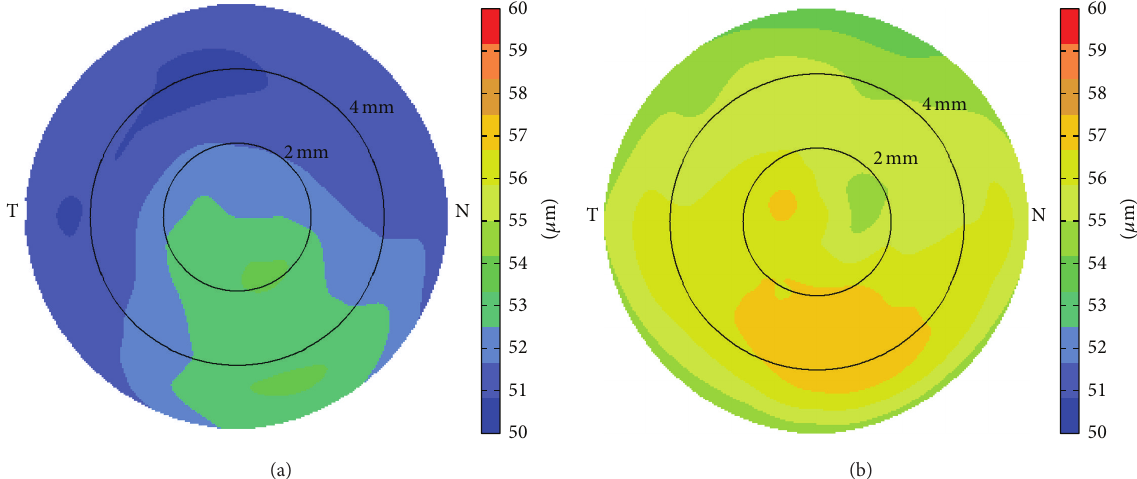
Figure 1: Average epithelial thickness map (a) before LASIK and (b) 3 months after LASIK measured by a Fourier-domain OCT system.